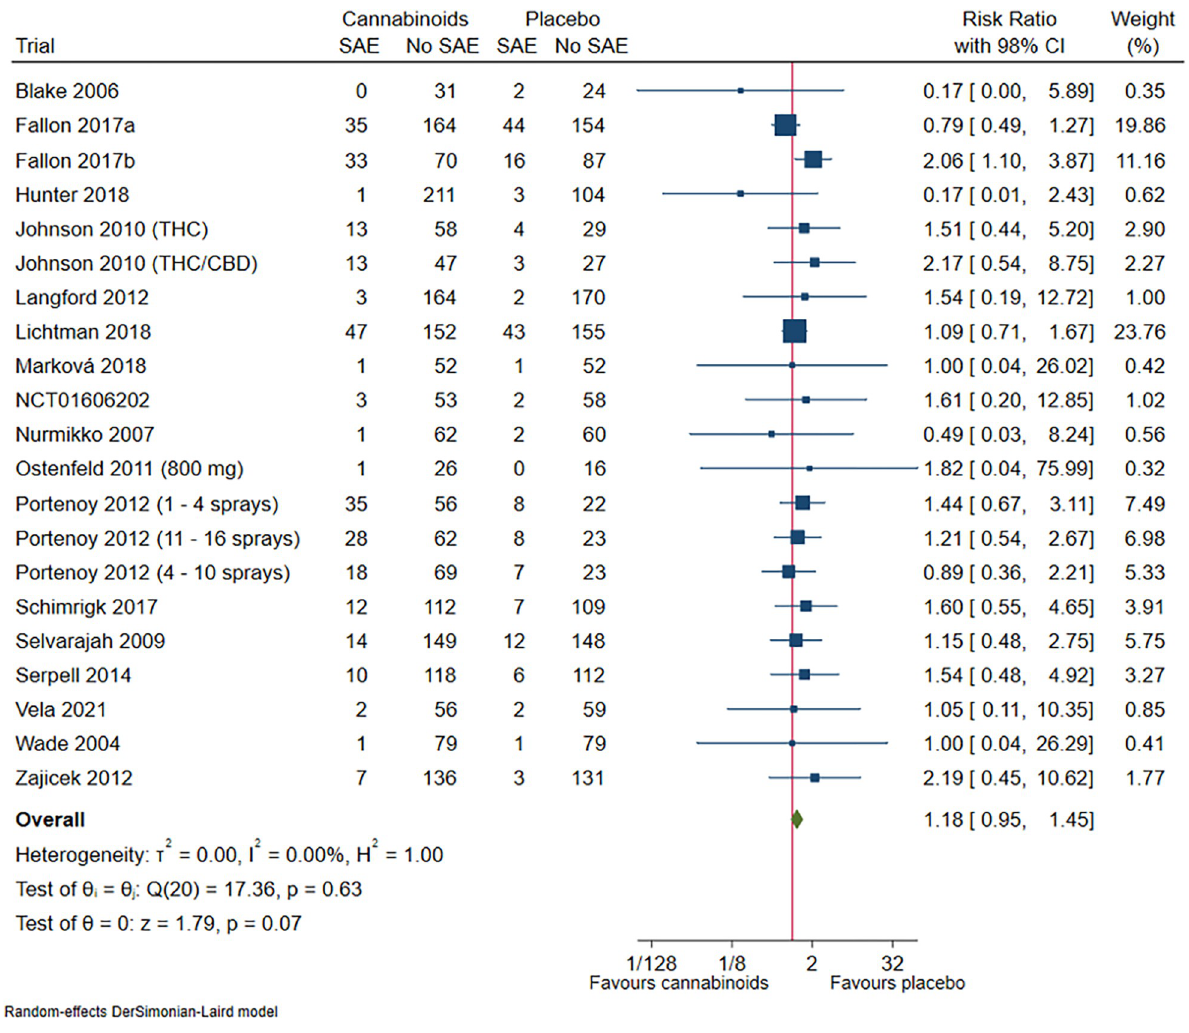
either EuroQol 5-D (3 trials) or EORTC-QLQC30 (1 trial). Meta-analysis showed no evidence of a difference between cannabinoids versus placebo (mean difference -1.38; 98% CI -11.8 to